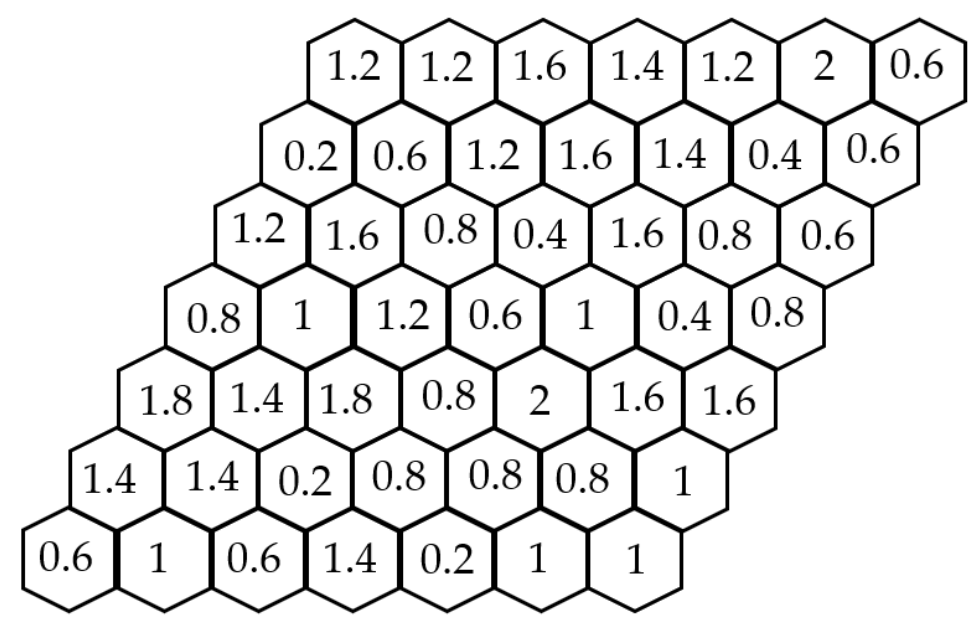
Figure 4. Nonuniform traffic distribution in cells.